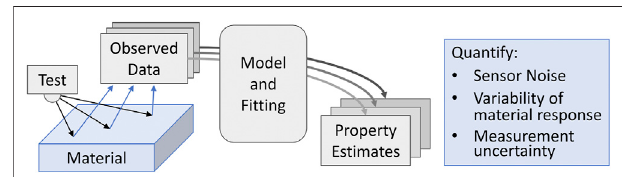
FIGURE 1 | A schematic drawing of the UQ, uncertainty quanti fi cation framework of the PIP experiments. The test is repeated at multiple locations within the sample to produce multiple observations of indentation pro fi lometry.Themodeland fi ttingprocedurearekept fi xedtoproducea set of property estimates that re fl ect the effects of different categories of uncertainty. The UQ will estimate the contribution of each category listed, as explained in Section 2.3